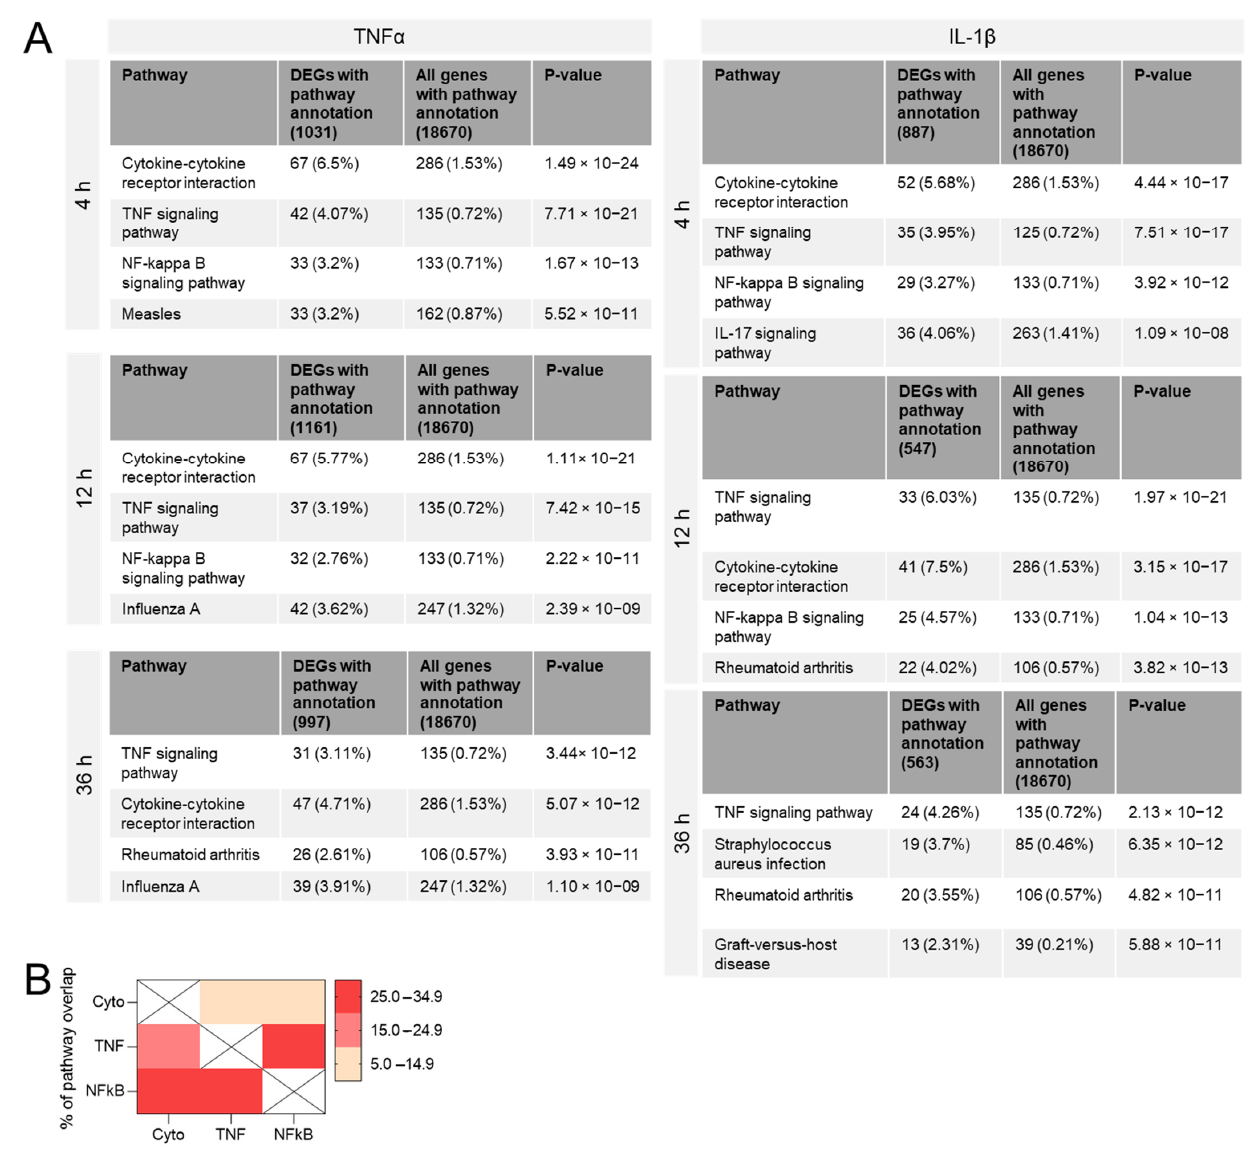
Figure 1. KEGG-pathway analysis of differentially expressed genes (DEGs) in human cortical spheroids stimulated with the pro-inflammatory cytokines TNF α or IL-1 β for 4 h, 12 h, or 36 h. ( A ) In each case, the top-4 KEGG pathways (based on false discovery rate (FDR)–corrected p -value) are shown. On the basis of this pathway analysis and an FDR p -value cut-off of 10 − 11 , we selected the three most frequent (core) KEGG pathways for further analysis, namely “Cytokine-cytokine receptor interaction” (Cyto; ko04060), “TNF signaling pathway” (TNF; ko04668) and “NF-kappa B signaling pathway” (NF κ B; ko04065). ( B ) Degrees of overlap between the DEGs from the three selected core KEGG pathways.